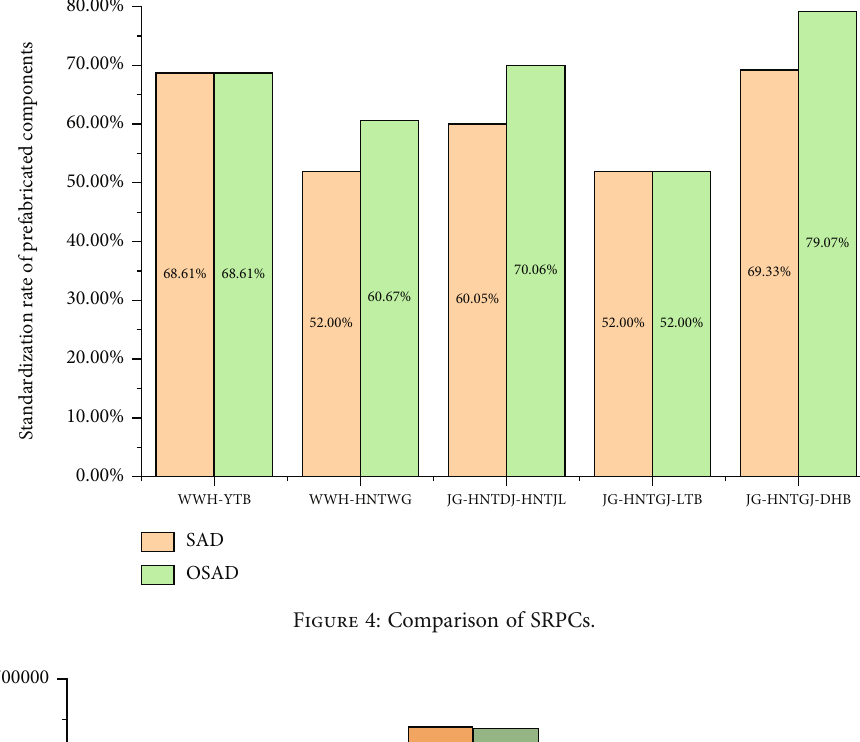
Figure 4: Comparison of